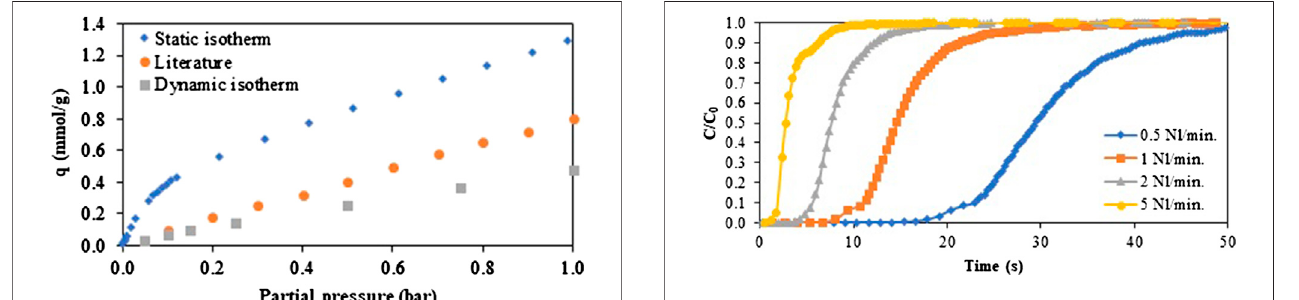
FIGURE 4 | Comparison of CO 2 -isotherms on zeolitic imidazolate framework-8 at 25 ° C. Isotherm measured under static conditions (blue), isotherm reported in literature (McEwen et al., 2013) (orange) and isotherm measuredunderdynamicconditionsfor5,10,15,25,50,75,and100v% of CO 2 (1 Nl/min.)